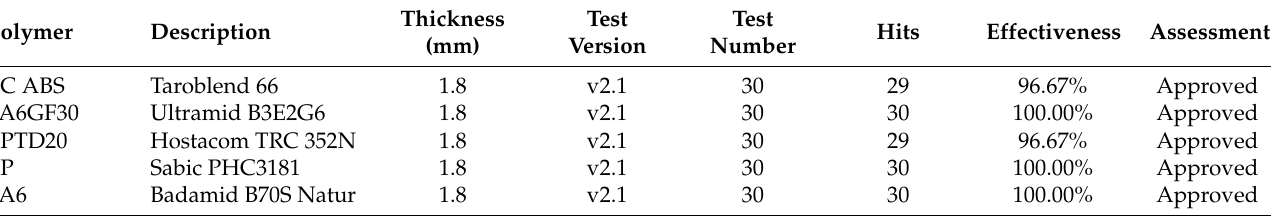
Table 5. Effectiveness tests for sensor